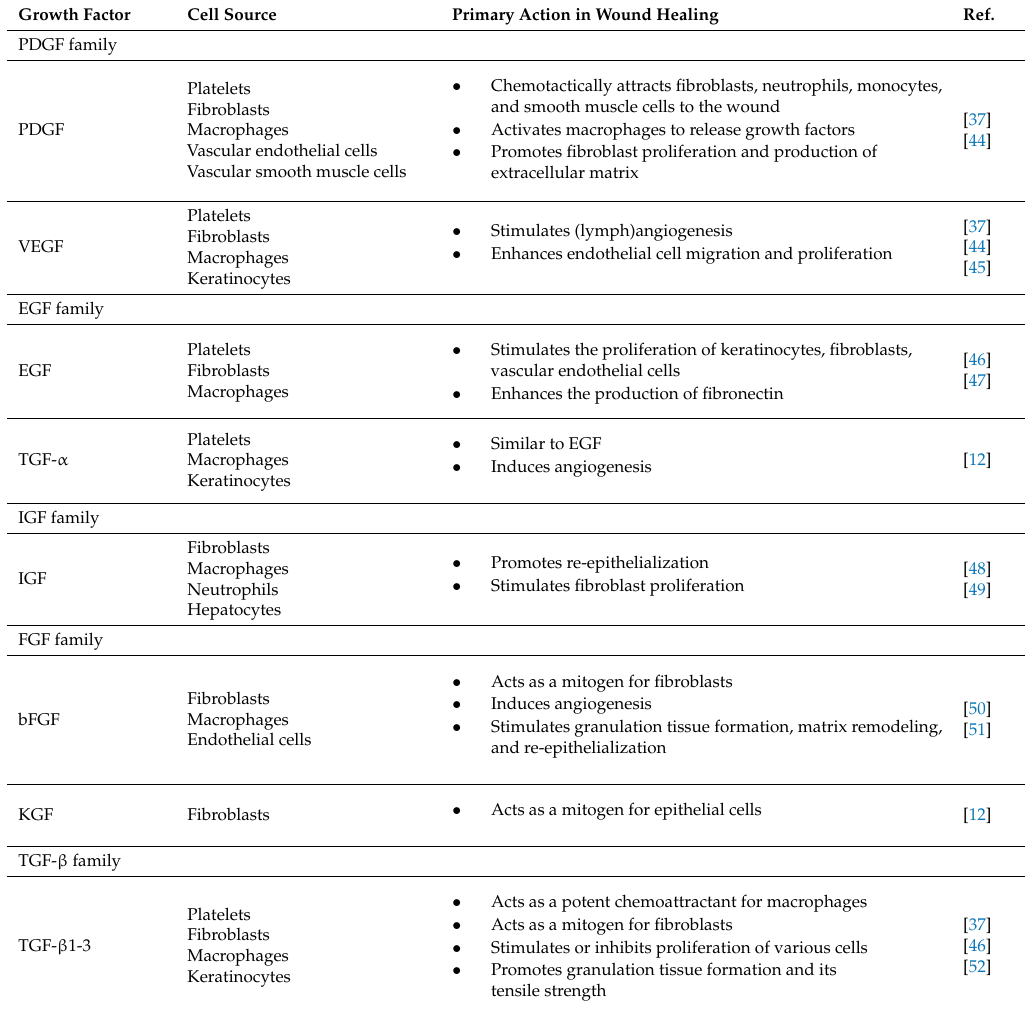
Table 1. Growth factors involved in wound healing and skin